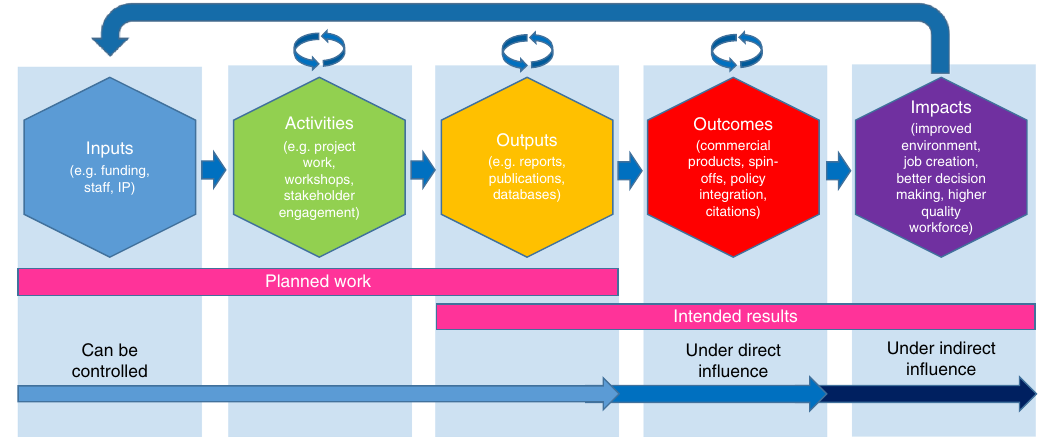
Fig. 1 The Research Impact Pathway (modi fi ed from ref. 2